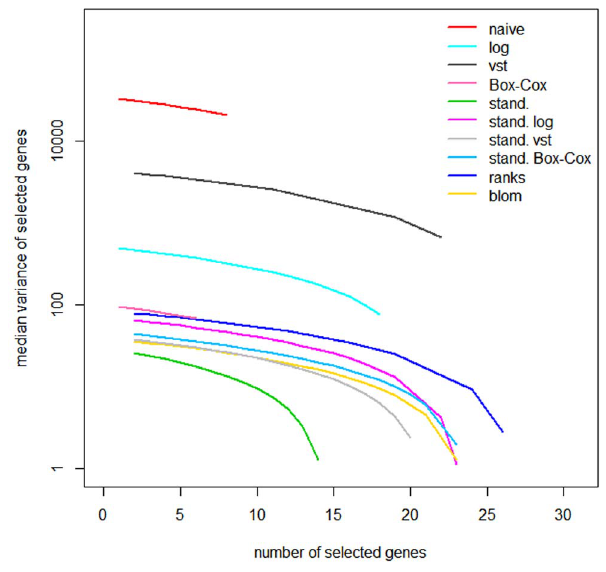
Figure 4. Selected genes in the KIRC data. Median variance of selected genes plotted against the number of selected genes in 50 resampling datasets. We used a smoothing spline on the scatterplot for better visualization of the